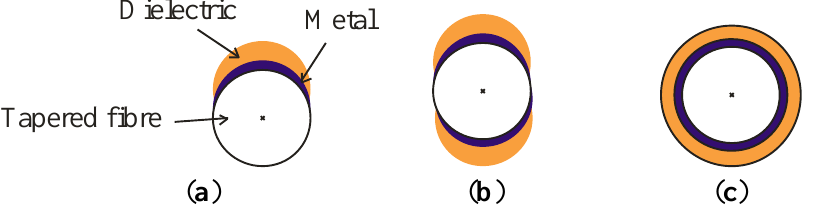
Figure 2. Different options for the geometry of the deposit on the tapered